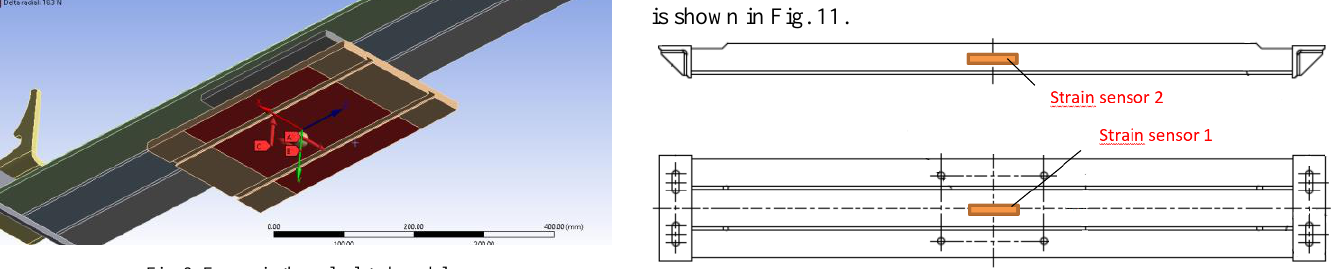
Fig. 11. Placement of the strain sensors on the coil fixing